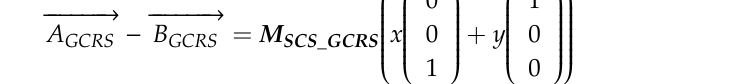
−−→ −−→ S ( t ) − A ( t ) (cid:107)